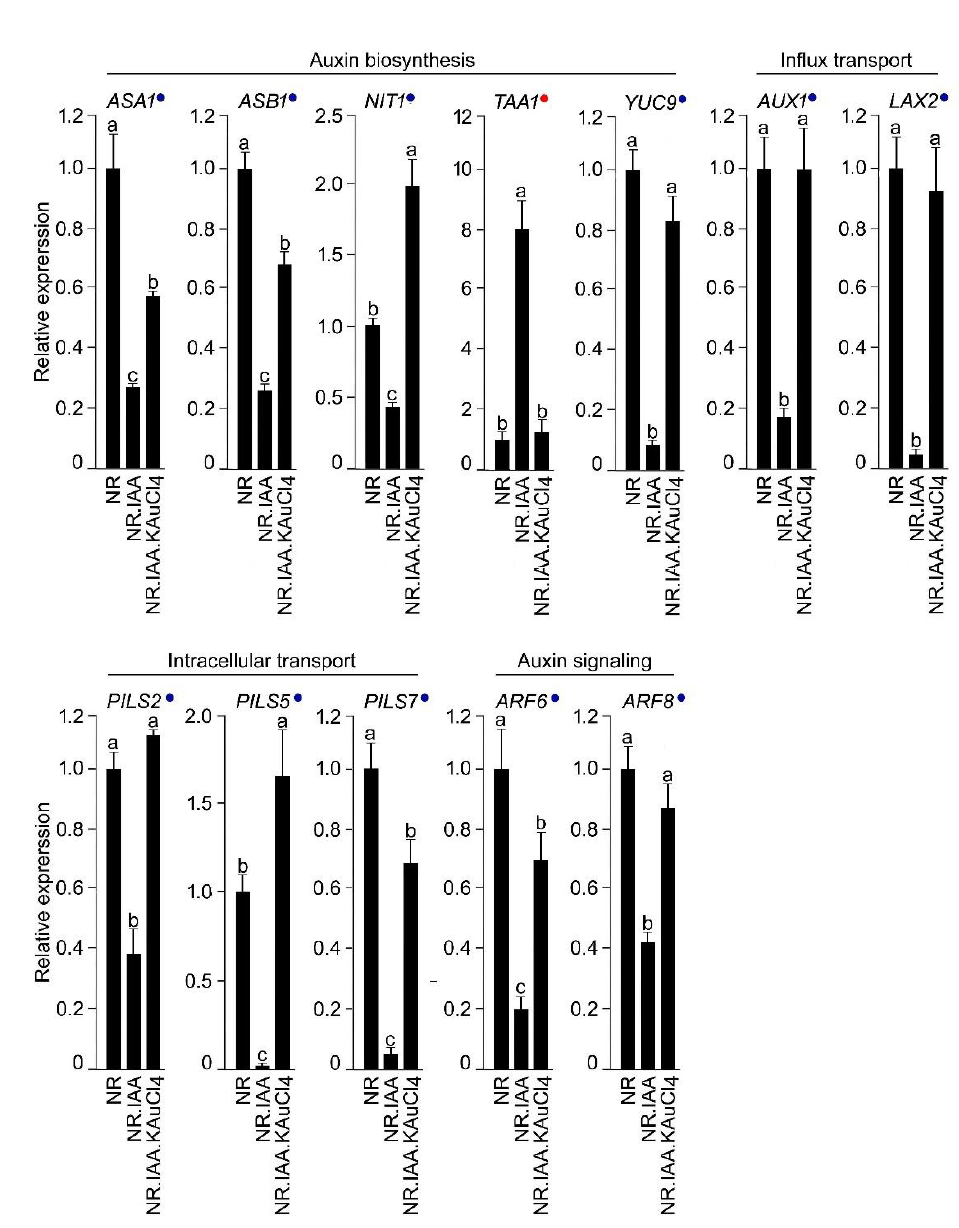
Figure 9. Differential recuperating effects of KAuCl 4 on IAA-mediated effects on the genes involved in the auxin pathway in the root. Wild-type Arabidopsis seedlings were hydroponically grown in the NR medium for 7 d and then transferred to NR, NR.IAA, and NR.IAA.KAuCl 4 for a further 7 d, as described in the legend of Figure 5. Roots were harvested, and the relative expression levels of the genes involved in auxin biosynthesis, its influx, intracellular transporters, and signaling were assayed by qRT-PCR. ACT2 was used as an internal control. Values are means ± SE ( n = 6) and different letters on the histograms indicate significant differences ( p < 0.05). Blue and red dots on the histogram indicate the suppression and induction of the genes, respectively, in response to NR.IAA treatment and their subsequent recuperation upon treatment with NR.IAA.KAuCl 4 .